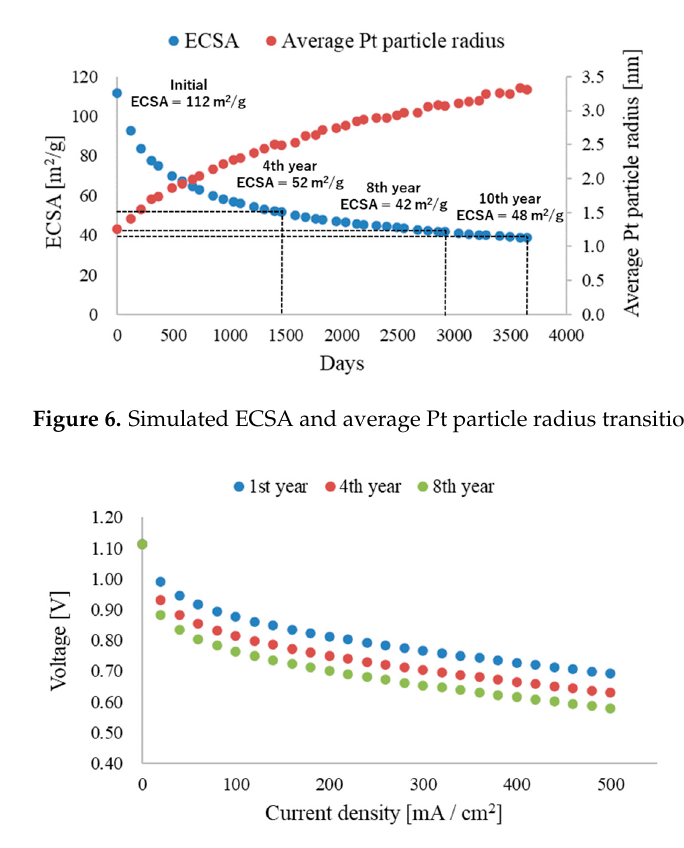
Figure 7. The I-V characteristics transition due to Pt catalyst degradation.